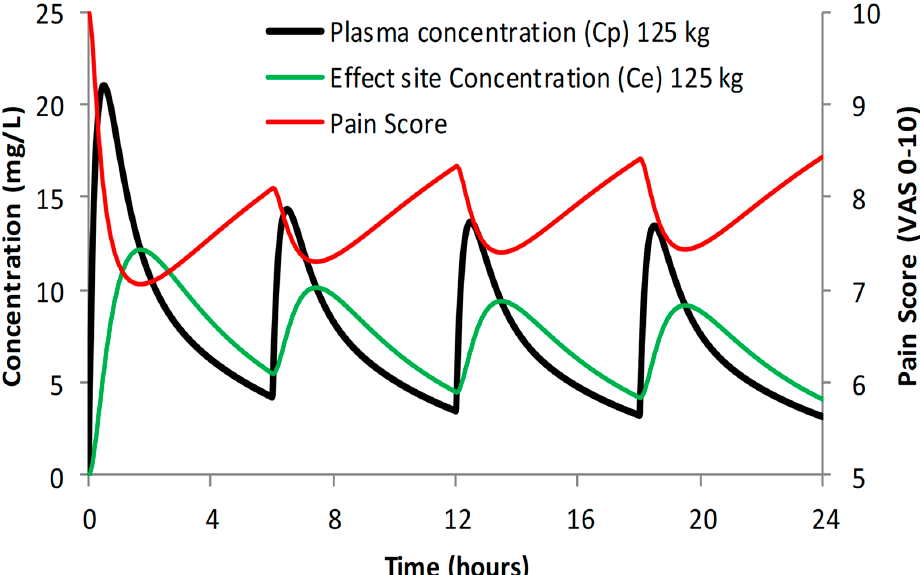
Figure 5. Simulation to demonstrate that an obese teenager (125 kg) administered a loading dose of acetaminophen of 2000 mg with a maintenance dosing of 1000 mg 6-hourly will not reach the target concentration of 10 mg/L at steady-state conditions. There will be a mean pain score decrease of 2 (VAS 0–10) and while this is a meaningful pain decrease, it is a small decrease and will require supplementation from other analgesic drugs.